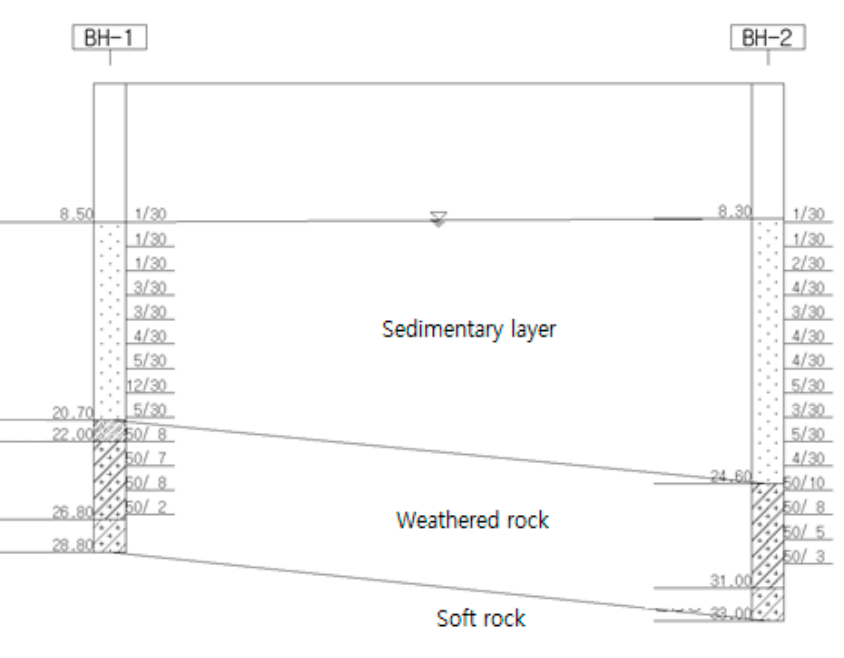
Figure 7. Stratum section view.